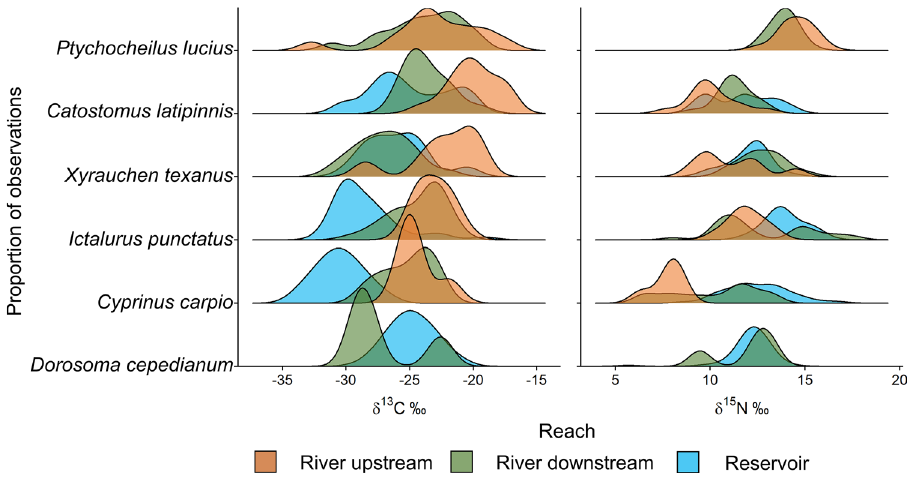
Figure 3. Density ridgeline plots showing distribution of δ 13 C and δ 15 N of species among the three sampled habitats in the San Juan River and Lake Powell reservoir. The top three species are native to the Colorado River